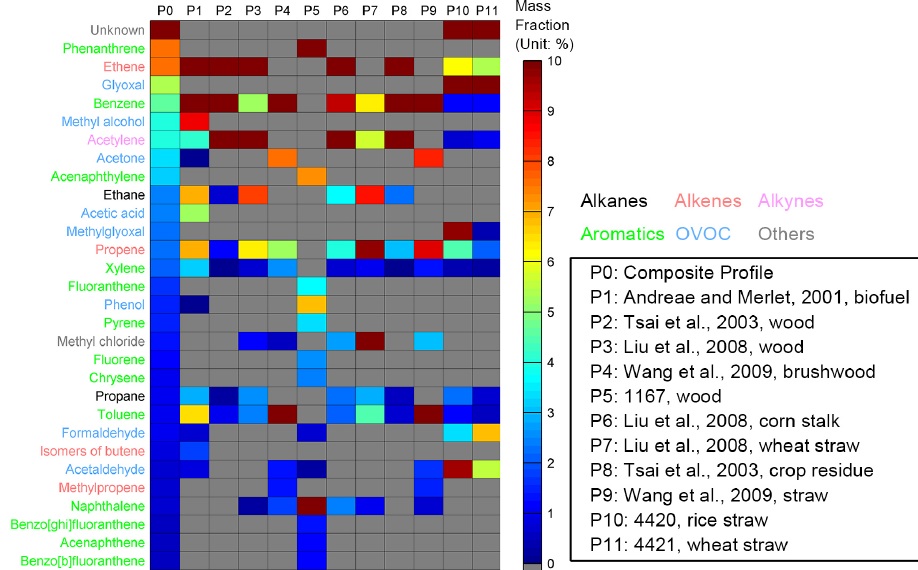
Figure 4. Mass fraction of major species in the profiles for the residential biofuel combustion. Top 30 species are presented and ranked decreasingly based on the mass fraction in the composite profile (P0). Gray grids indicate that mass fractions for these species are not included in the